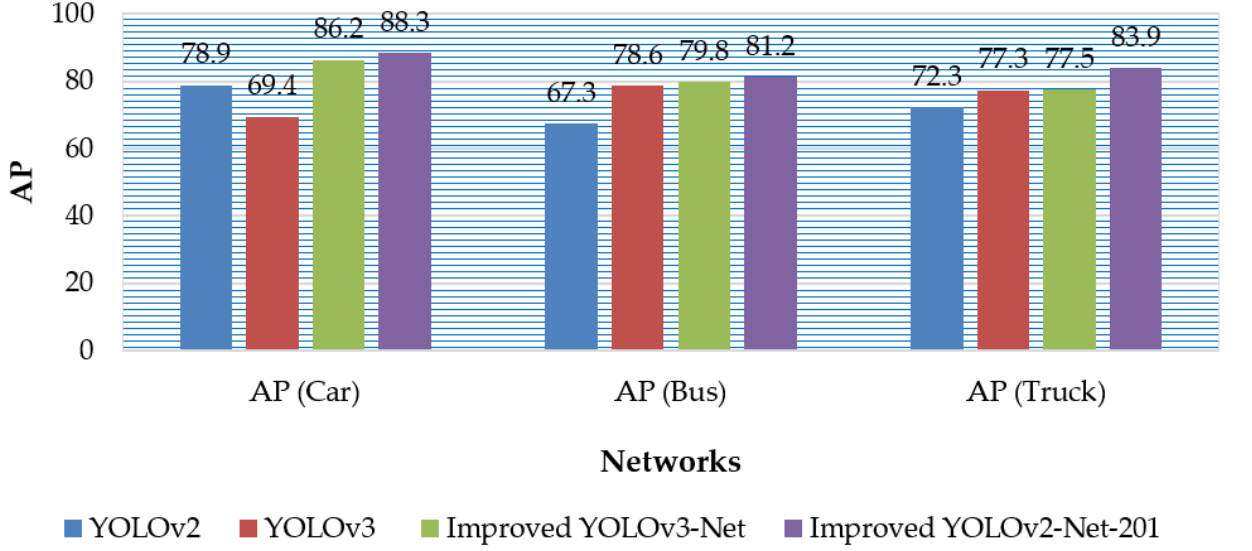
Figure 9. Comparison Graph with existing models for Car, Bus, and Truck samples using the PASCAL VOC dataset.